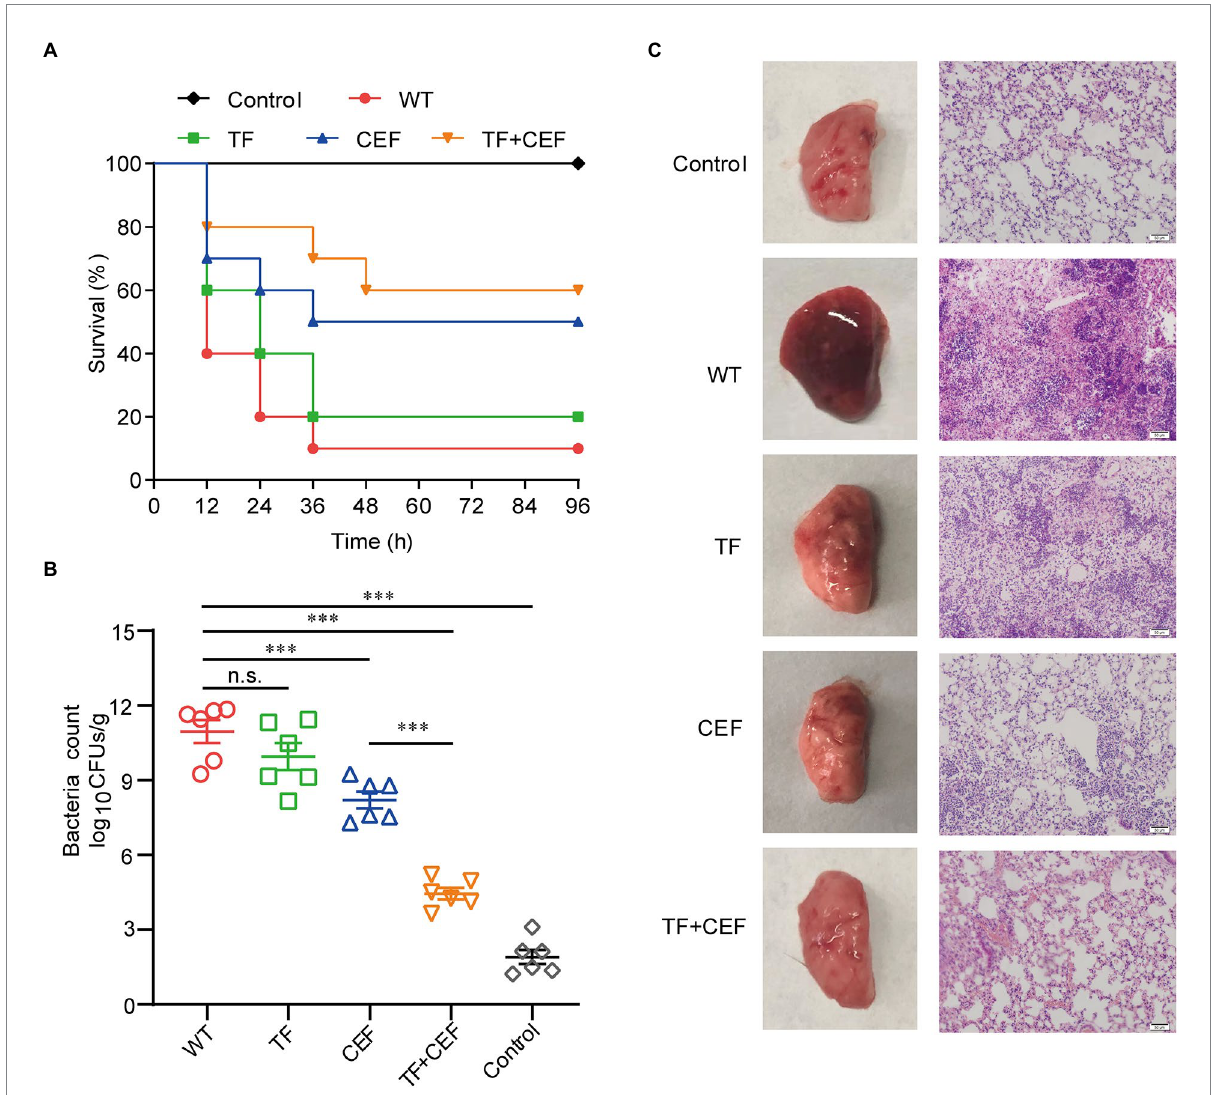
FIGURE 5 The effects of combination therapy. (A) Survival rate of mice at 96 h ( n = 10). (B) Bacterial load counts in the lung tissues ( n = 6). (C) Pathological changes and histopathology analysis of lung tissues. Scale bar = 50 μ M. Data are presented as mean ± SD (n=3) , n.s., no significant difference; *** p